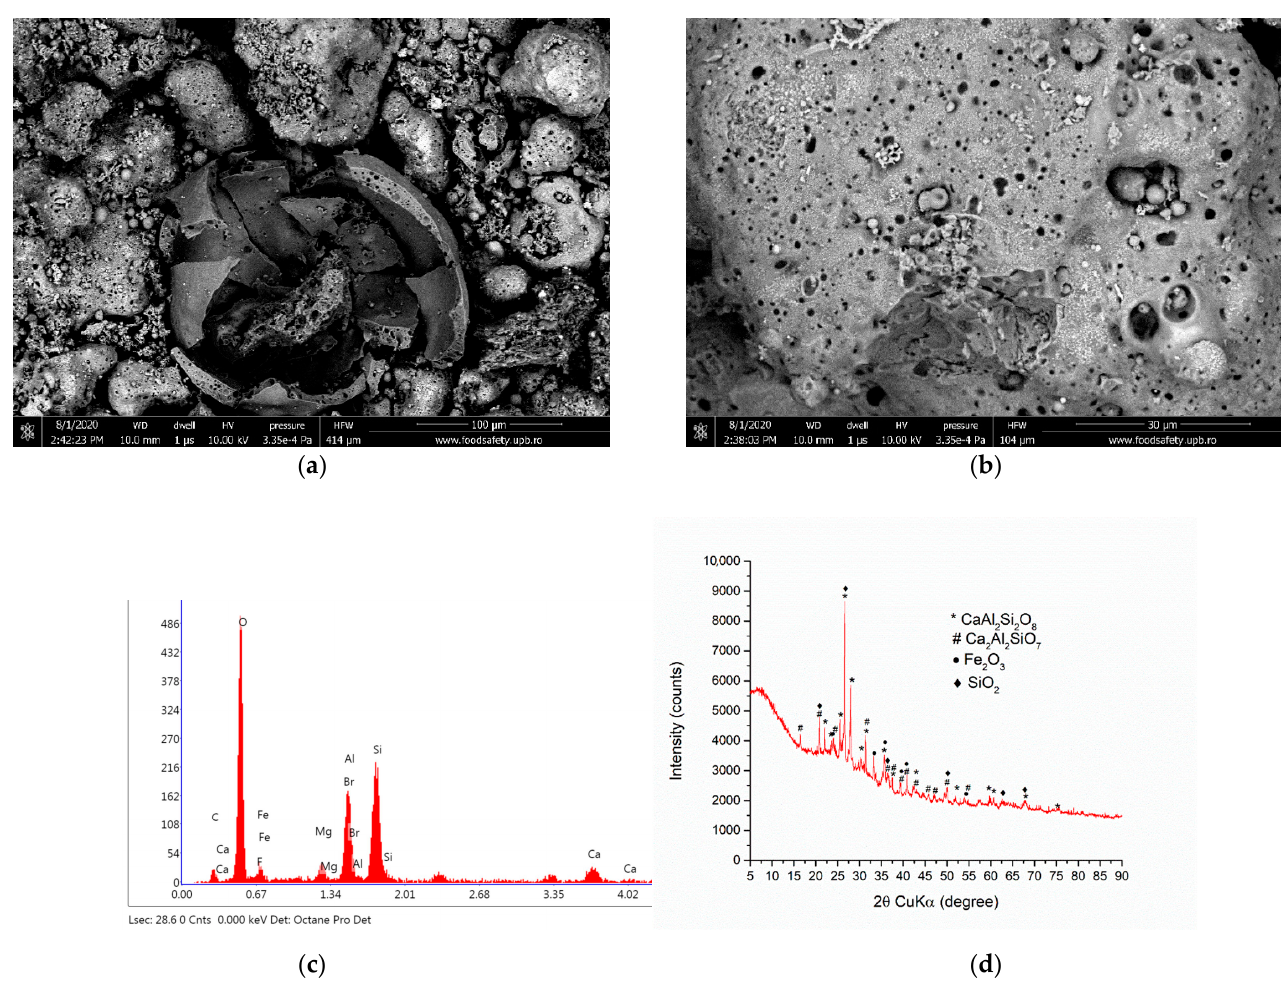
Figure 1. Secondary Electron Images ( a , b ), EDS spectra ( c ), and XRD pattern ( d ) of the ash sample. Table 1. Semi-quantitative analysis as determined by XRD.